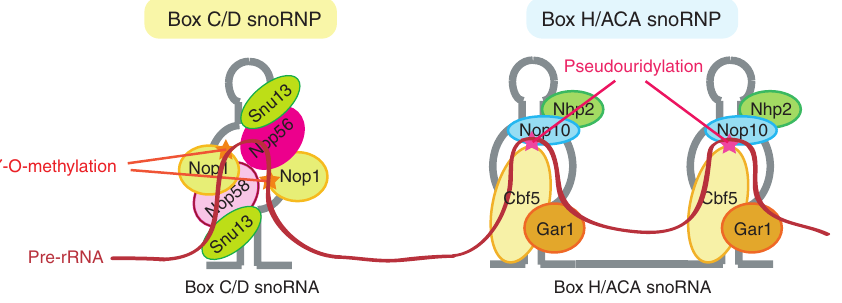
Figure 2 Components of the box C/D and box H/ACA